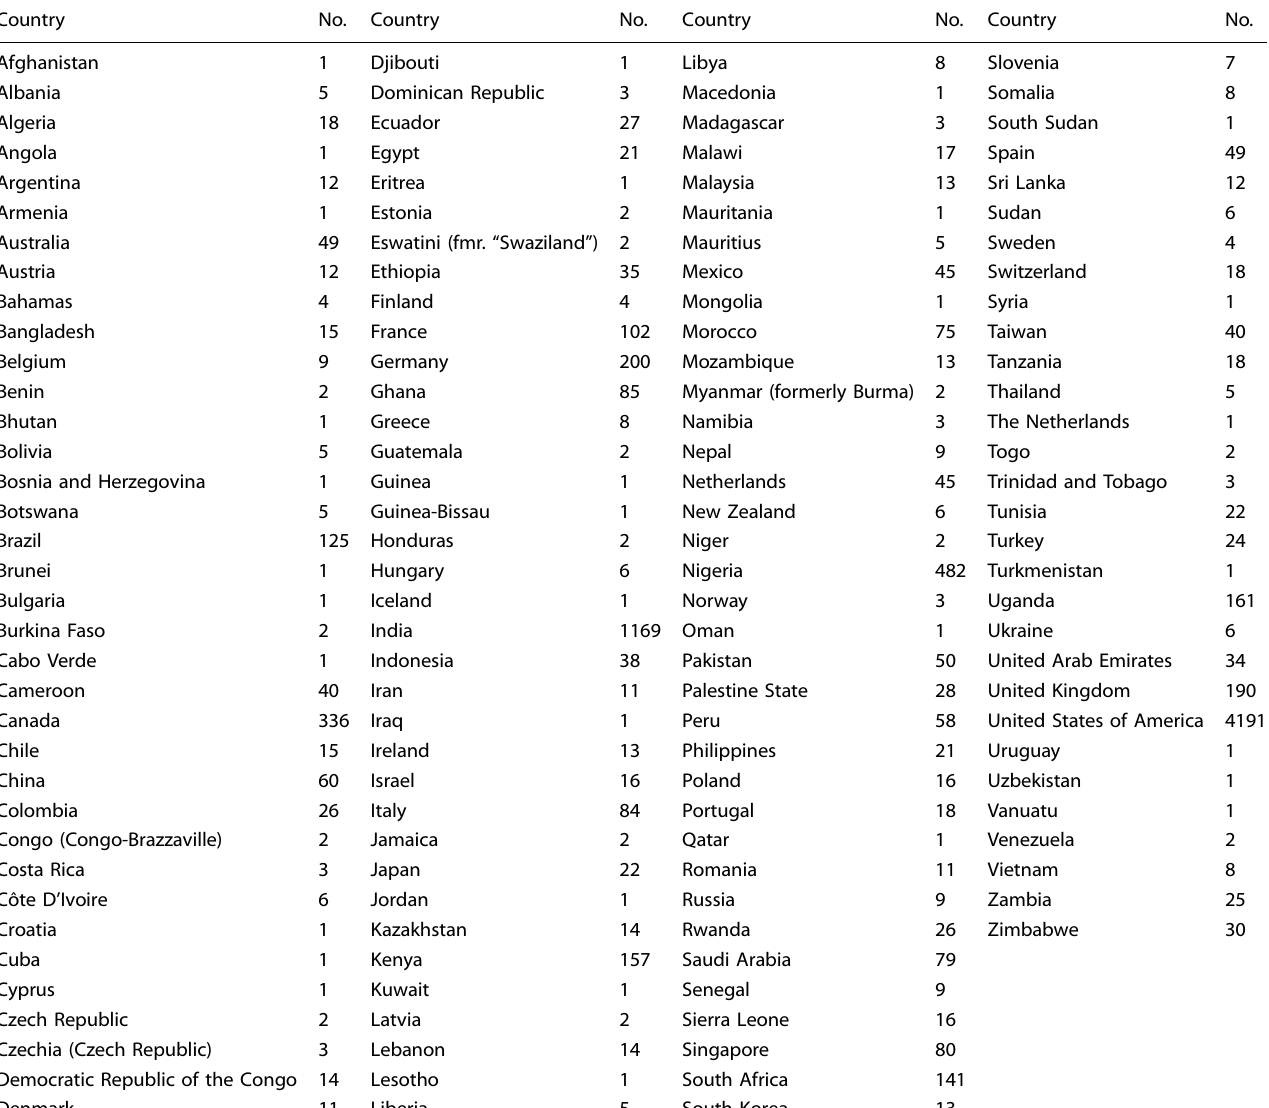
Table 1. Total number of applicants by country across three MIT COVID-19 Challenge